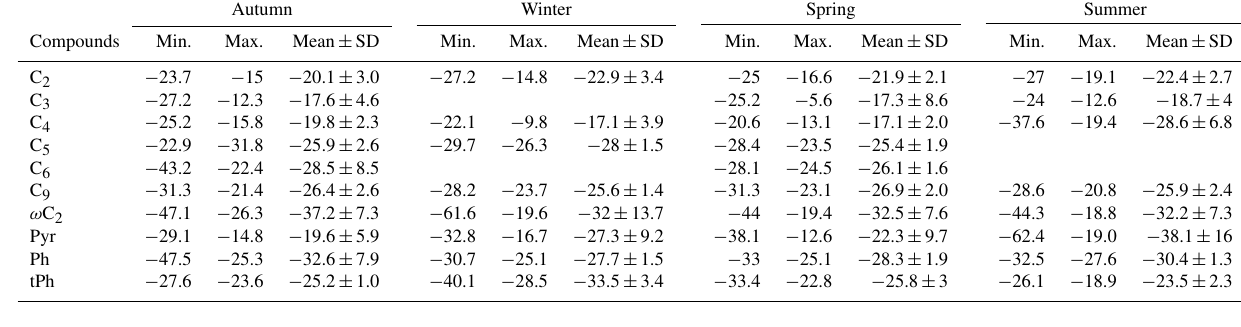
Table 5. Stable carbon isotopic compositions ( δ 13 C, ‰) of major compounds in PM 2 . 5 in Beijing. Autumn Winter